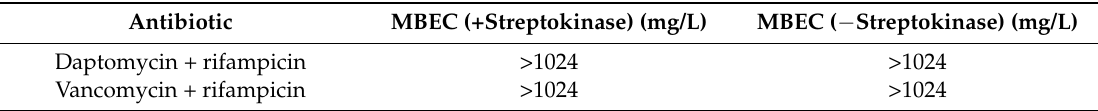
Table 2. MBEC against biofilms of S. aureus USA 300 grown for 24 h in tryptic soy broth (TSB) and incubated with antibiotics in the presence or absence of streptokinase. Rifampicin was added at a fixed dosage of 10 mg/L.